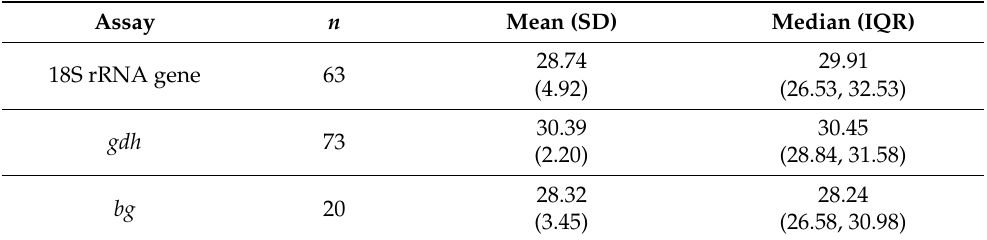
Table 3. Recorded cycle threshold (Ct) values of the real-time screening PCR assays targeting G. duodenalis . Assay n Mean (SD) Median (IQR)